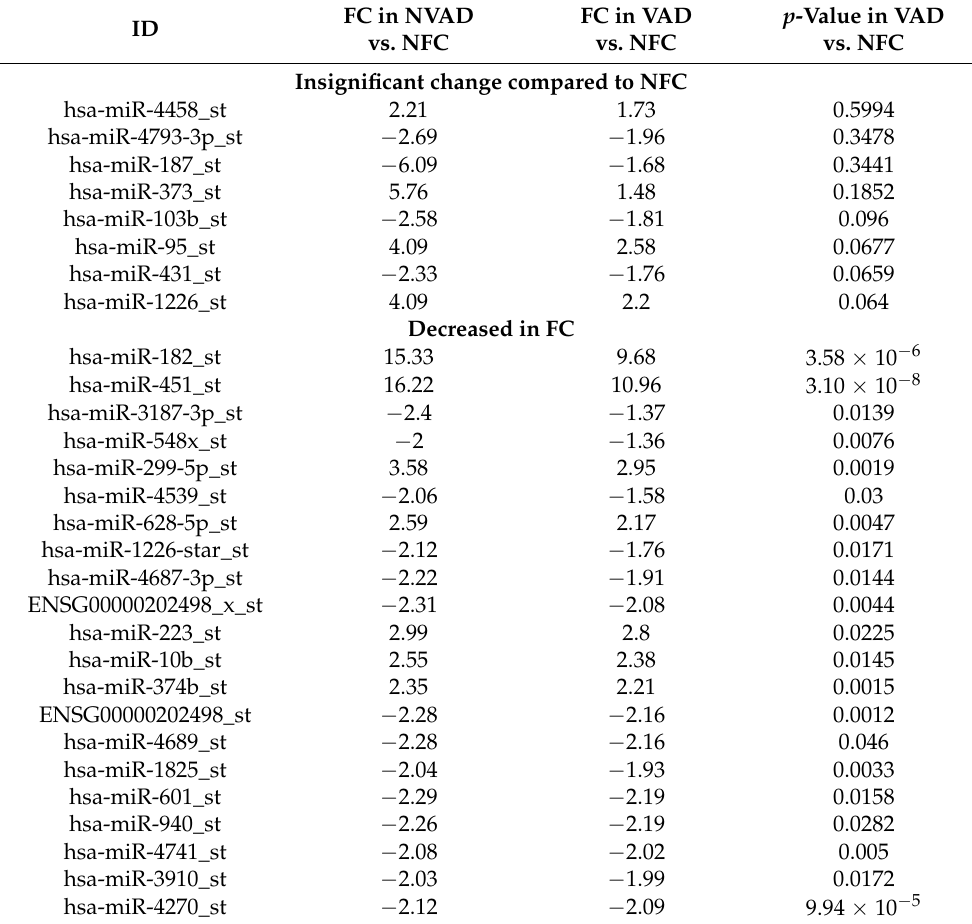
Table 4. Changes in pathological miRNA expression post-LVAD implantation in the LV.